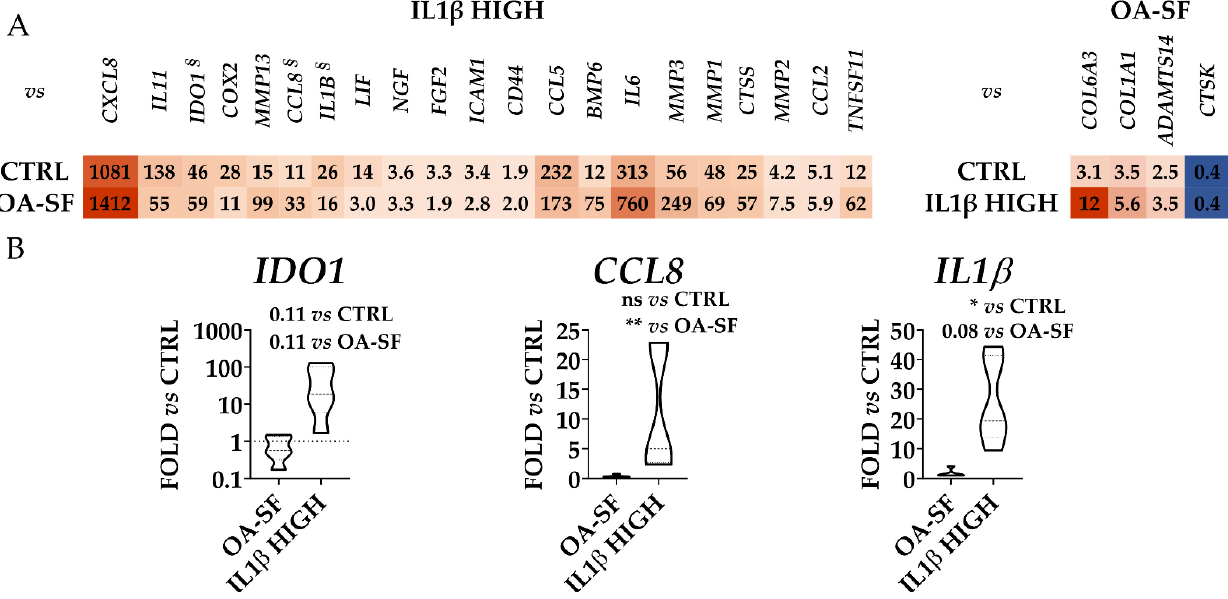
Figure 8. Differential expression of IL1 β HIGH and OA-SF-specific genes (only those significantly modulated vs. each other in Figures 4 and 5) with respect to control (CTRL) and the other treatment for the five HCH donors. ( A ) Red shades indicate higher expression ratios and blue shades indicate lower expression ratios with respect to the other conditions. Color key indicates the intensity associated with expression ratios. Mean values are shown. p-value for each shown ratio can be found in Supplementary Table S5. ( B ) Violin plots show the expression of the genes with p-values > 0.05 in one or both ratios (§ in panel A). * for p- value ≤ 0.05, ** for p- value ≤ 0.01.